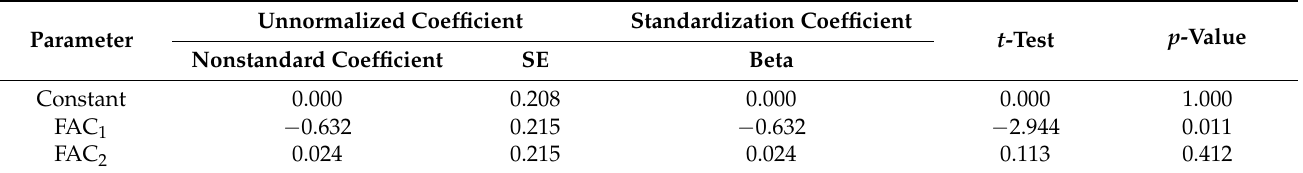
Table 8. OLS regression results of principal